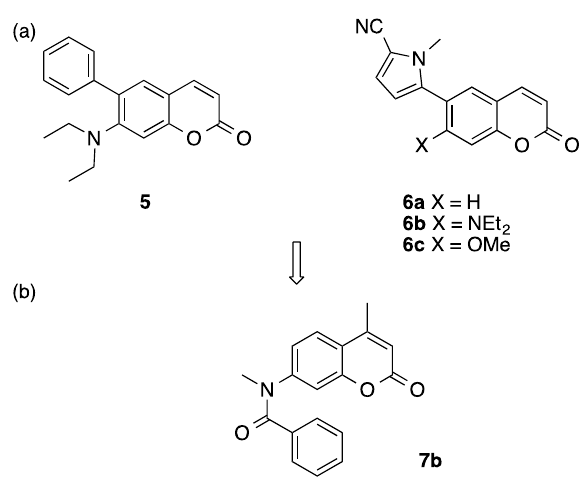
Figure 2. Structures of ( a ) 6-arylcoumarin derivatives 5 and 6 with progesterone receptor (PR)-antagonistic activity and ( b ) androgen receptor (AR)-antagonistic coumarin 7 .